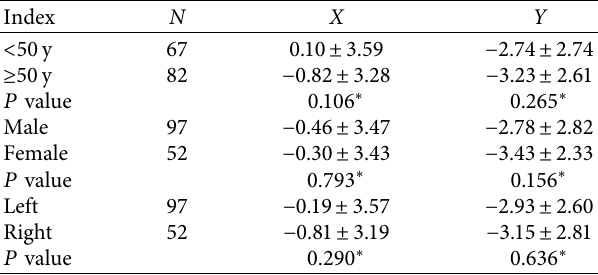
Figure 2: Lateral-skull surface and coordinate of point E; (a) on the lateral surface of the 3D image, with the line of sight perpendicular to the plane near the keypoint, the following points were marked: the midpoint of the posterior edge of the external auditory canal (point G), the mastoid process apex (point H), the digastric groove apex (point I), and the asterion (point J). All these landmarks were close to the keypoint, meaning they were easy to palpate intraoperatively. (b) Line GJ was the x -axis; a point below one-third of the GJ-line segment was the origin; and a perpendicular line running from the origin was the y -axis. Te coordinate system was then established. (c) Te coordinates of point E were determined via the coordinate system using a workstation. Table 1: Comparison of measurement results of diferent genders and